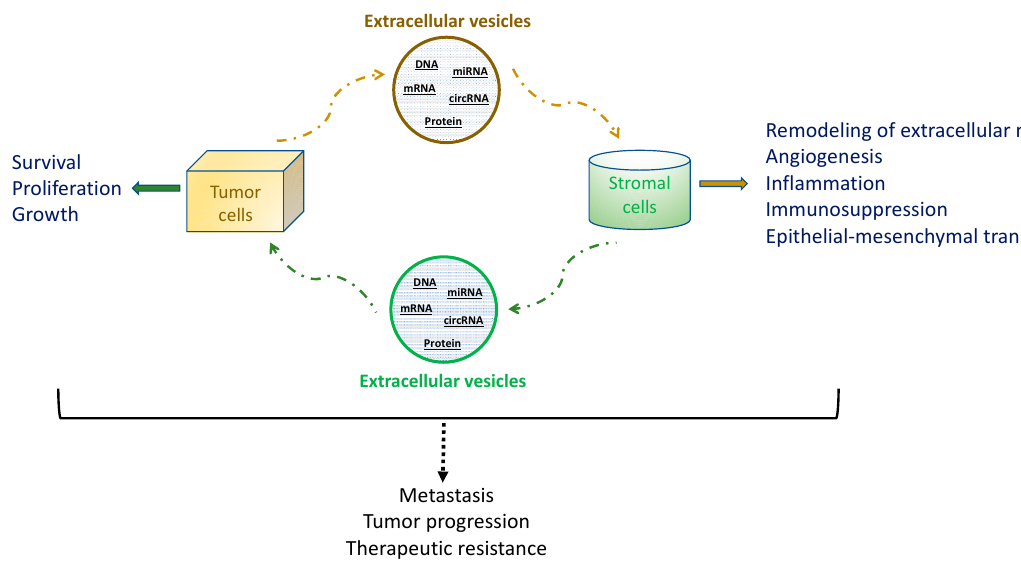
Figure 1. Roles of EVs in intercellular communication between tumor cells and stromal cells in local and distant microenvironments, leading to tumor metastasis, progression, and resistance to treatment.